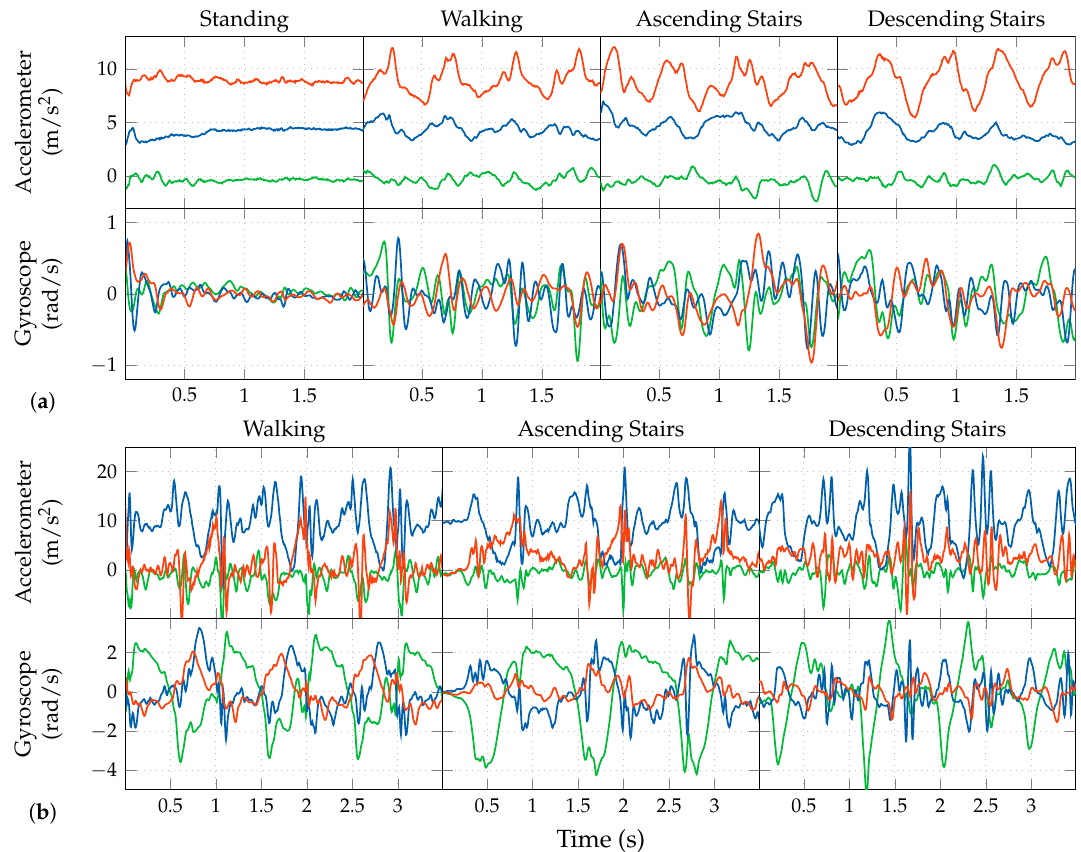
Figure 2. Raw sensor data sequences of the covered activities in hand-case ( a ) and pocket-case ( b ). Green, blue, and red represent the device’s local coordinate system axes x, y, and z